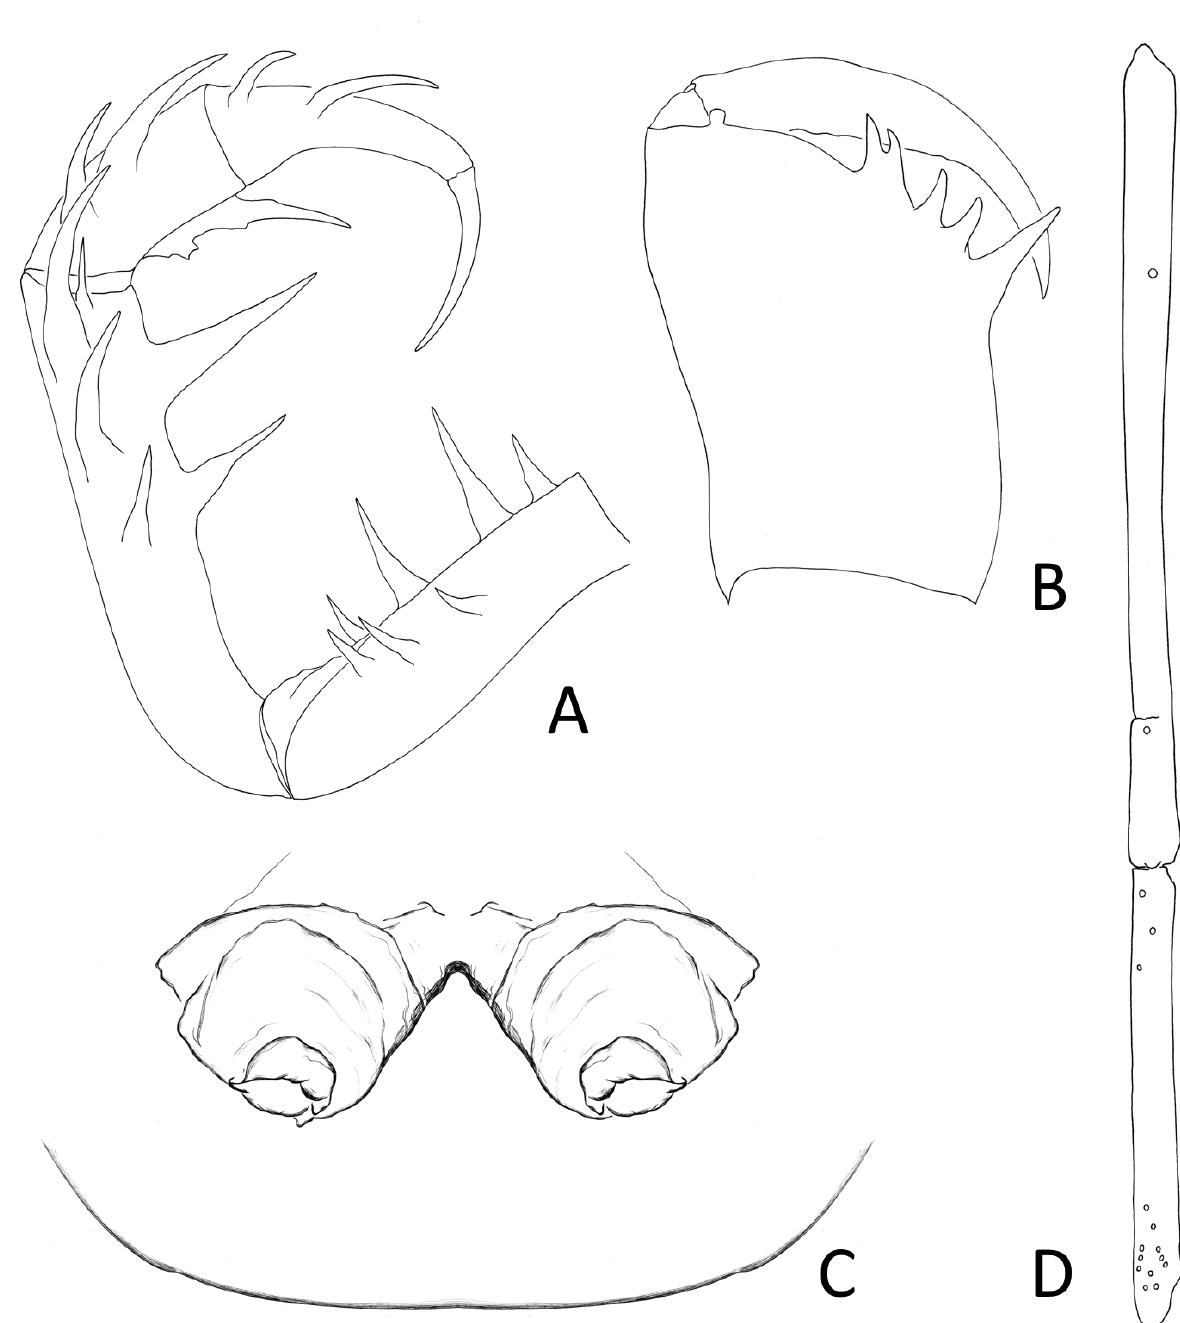
Figure 5. Female holotype of Charinus kakum sp. n.: A , left pedipalp in prolateral view; B , right chelicera in retrolateral view; C , female gonopods, dorsal view; and D , trichobothria patterns on leg